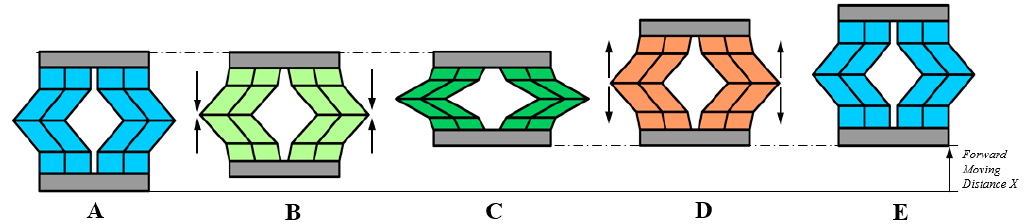
Figure 5. The schematic diagram of the linear movement pattern from the top view. ( A ) The original state; ( B ) The folding process of the left and right PFAs; ( C ) The folded state; ( D ) The unfolding process state; (B) The folding process of the left and right PFAs; (C) The folded state; (D) The unfolding of the left and right PFAs; ( E ) The unfolded state. process of the left and right PFAs; (E) The unfolded state.